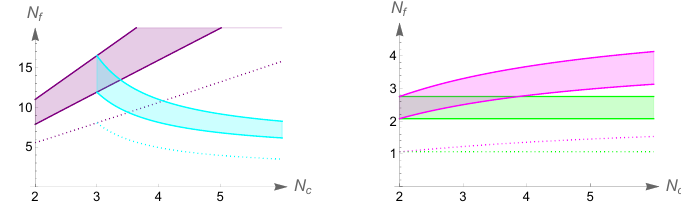
Figure 1. Estimates of phase diagrams as a function of numbers of colors and flavors for different fermion representations. The shaded regions show the conformal windows in the left panel for the fundamental (purple) and 2-index antisymmetric (cyan) representations, and for the adjoint and 2-index symmetric representations in the right panel. The dotted lines show where the second coefficient of the beta function changes